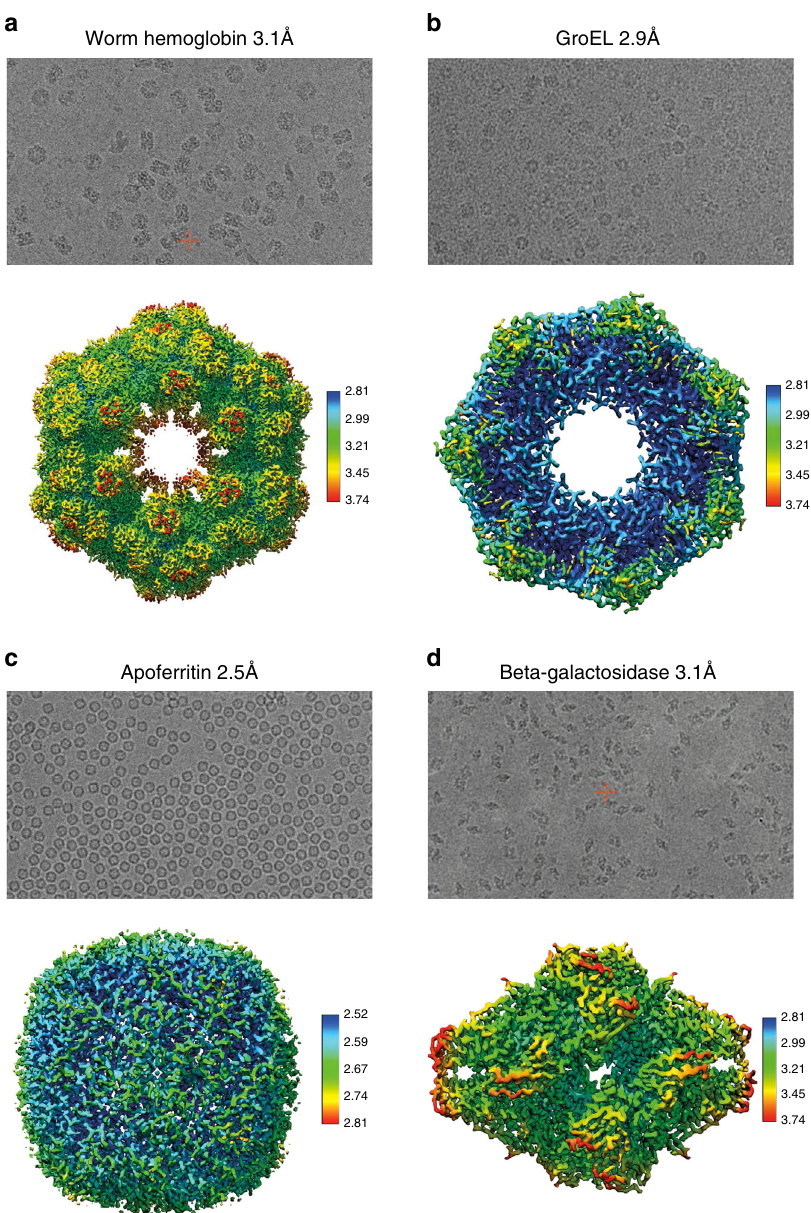
Fig. 4 Sample preparation of four standard proteins by the VitroJet, and validated by cryo-EM analysis. Micrographs (top) and reconstructions (bottom) of worm hemoglobin, GroEL, apoferritin, and beta-galactosidase. The reconstructions are colored according to local resolution as calculated using